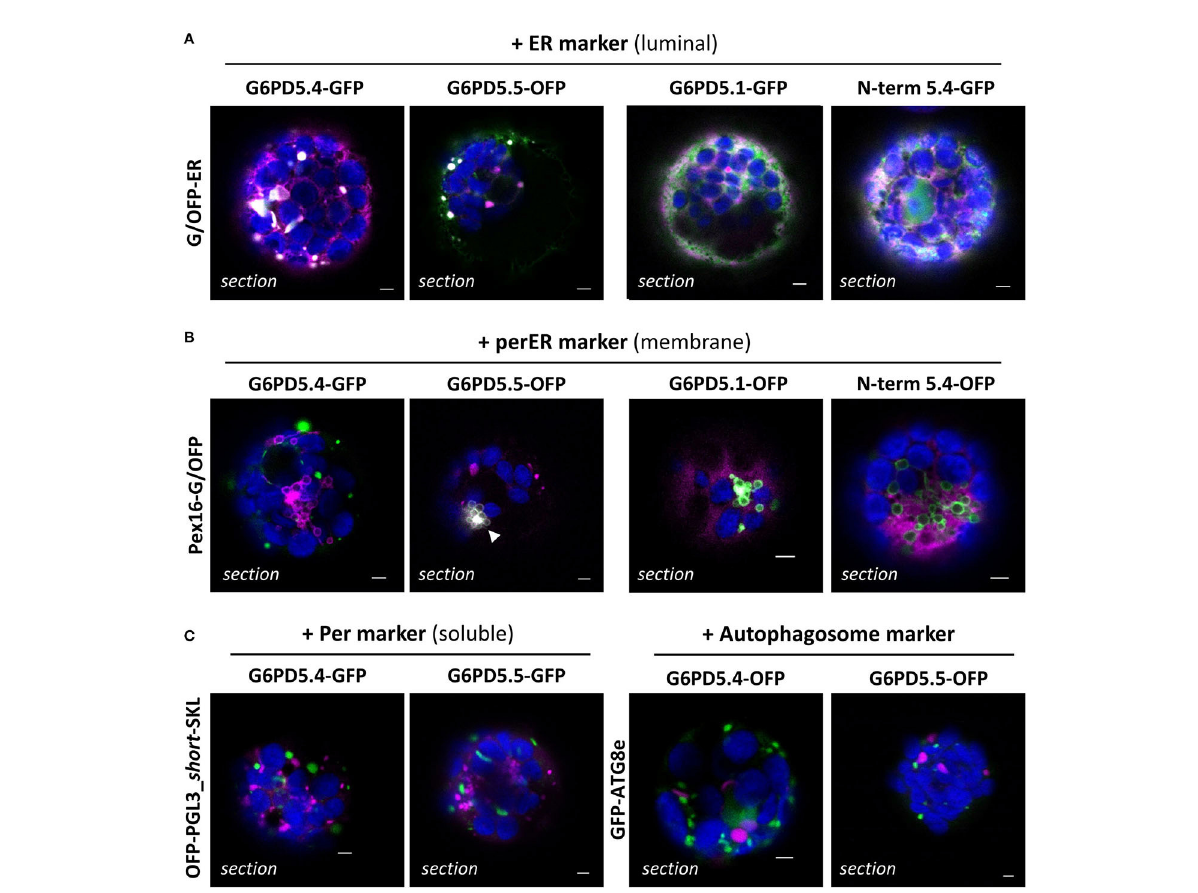
FIGURE4 Subcellular localization of the membrane-bound G6PD5.4 and G6PD5.5 reporter fusions. (A) Co-expression of the indicated G6PD5-reporter fusions with a luminal ER marker (GFP-ER or OFP-ER) showed local overlap with G6PD5.4 and G6PD5.5 (white signals), little with G6PD5.1, and some with the N-terminal G6PD5.4 part. (B) G6PD5.4 showed no overlap with Pex16 (marker of the peroxisomal ER), but G6PD5.5 did in some areas (white arrowhead). (C) Despite accumulating in spherical structures reminiscent of peroxisomes, neither G6PD5.4 nor G6PD5.5